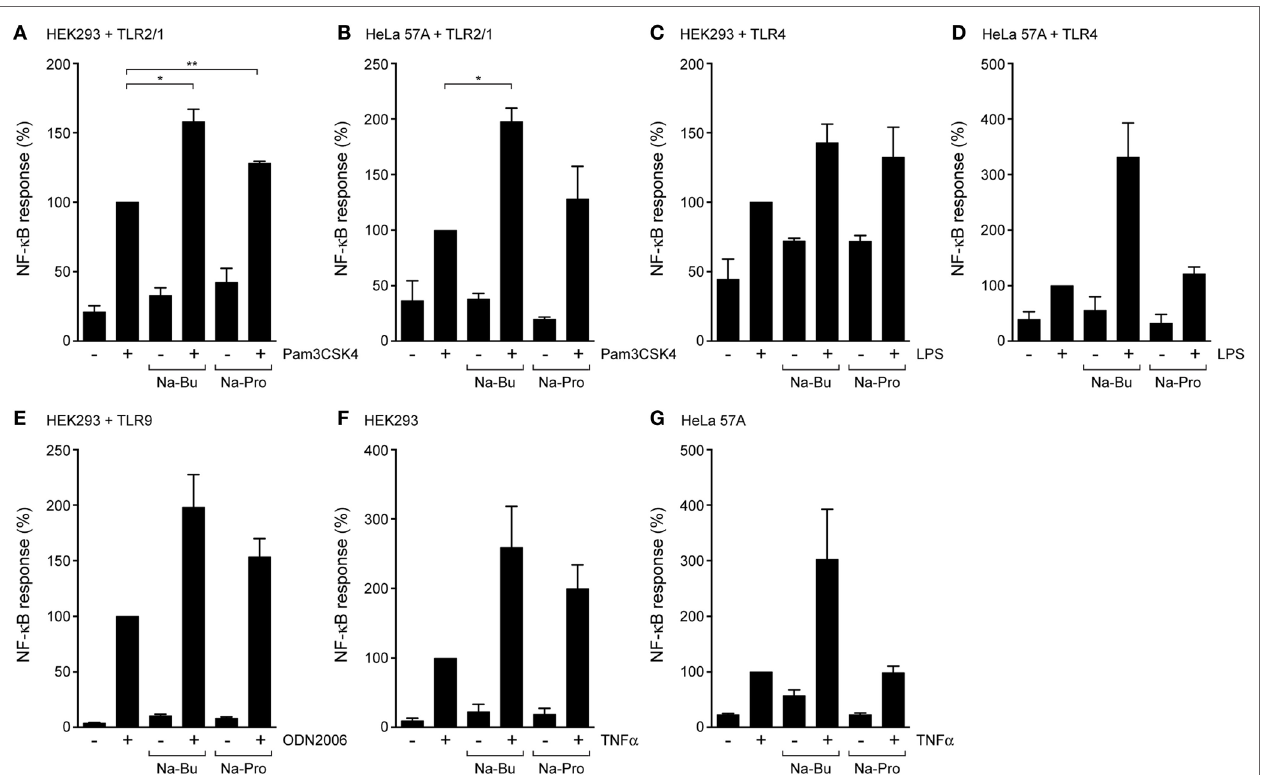
FigUre 2 | scFas enhance Tlr and TnF α responses in epithelial cells. TLR–NF- κ B assays in HEK293 or HeLa 57A expressing indicated TLR constructs and a NF κ B-luciferase reporter. Cells were incubated with 10 mM Na-Butyrate or Na-Propionate for 30 min followed by stimulation with the respective TLR ligands for 5 h. (a,B) TLR2/1-mediated NF- κ B activation in HEK293 or HeLa 57A cells in the presence and absence of SCFAs in response to stimulation with TLR2/1 ligand Pam3CSK4. (c,D) TLR4-mediated NF- κ B activation in HEK293 or HeLa 57A cells in the presence and absence of SCFAs in response to stimulation with TLR4